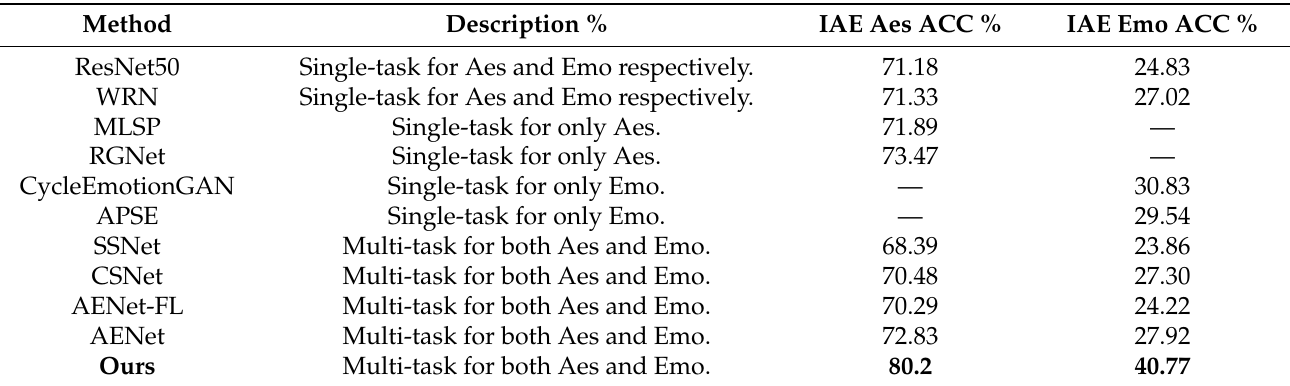
Table 2. Comparison on AVA for aesthetics assessment and on ArtPhoto for emotion recognition, respectively (aesthetics is abbreviated as Aes, emotion as Emo, and accuracy as